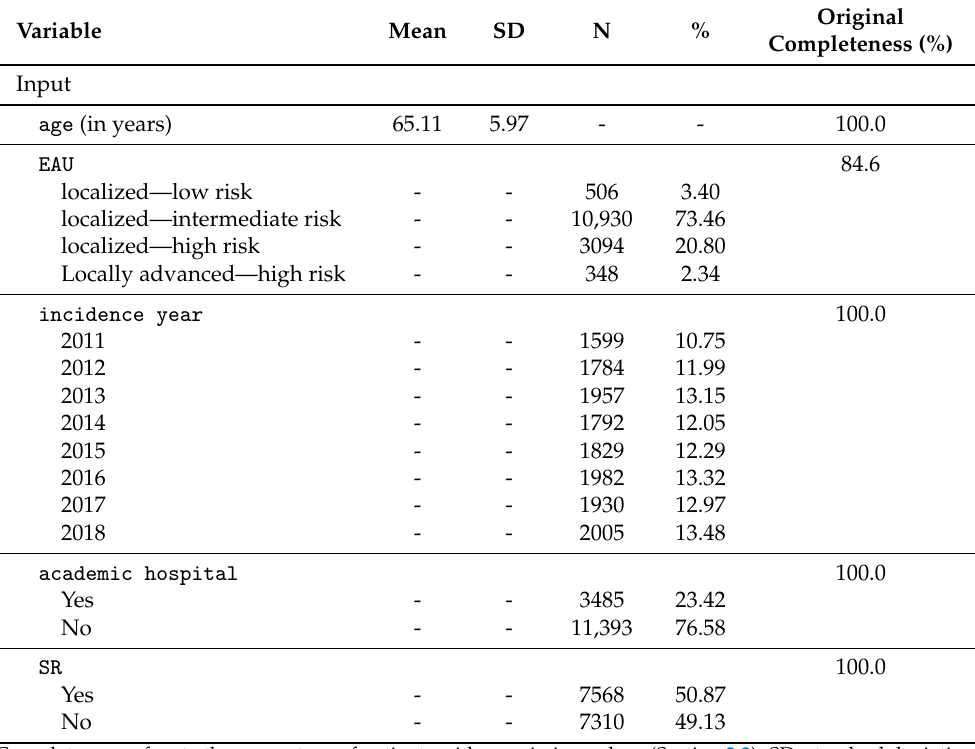
Table 2. General overview of the dataset used in this